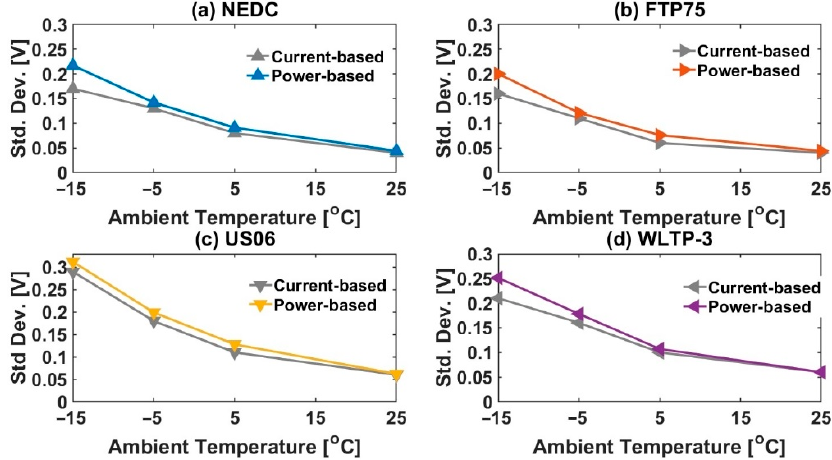
Figure 8. Comparison of standard deviation from mean cell voltage ( σ ) for various ambient temperatures and legislative drive cycles for 65% starting SOC employing current-based and power-based approaches: ( a ) NEDC, ( b ) FTP75, ( c ) US06 and ( d ) WLTP-3.